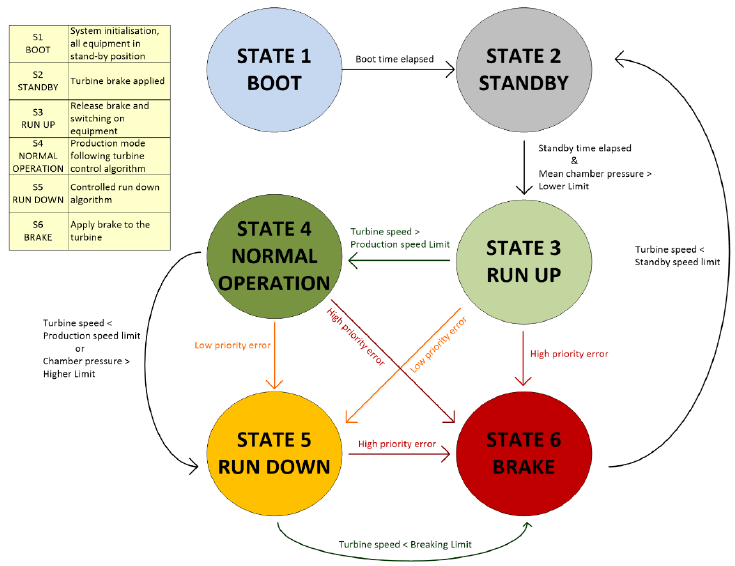
Figure 3. Diagram of the state machine executed by the